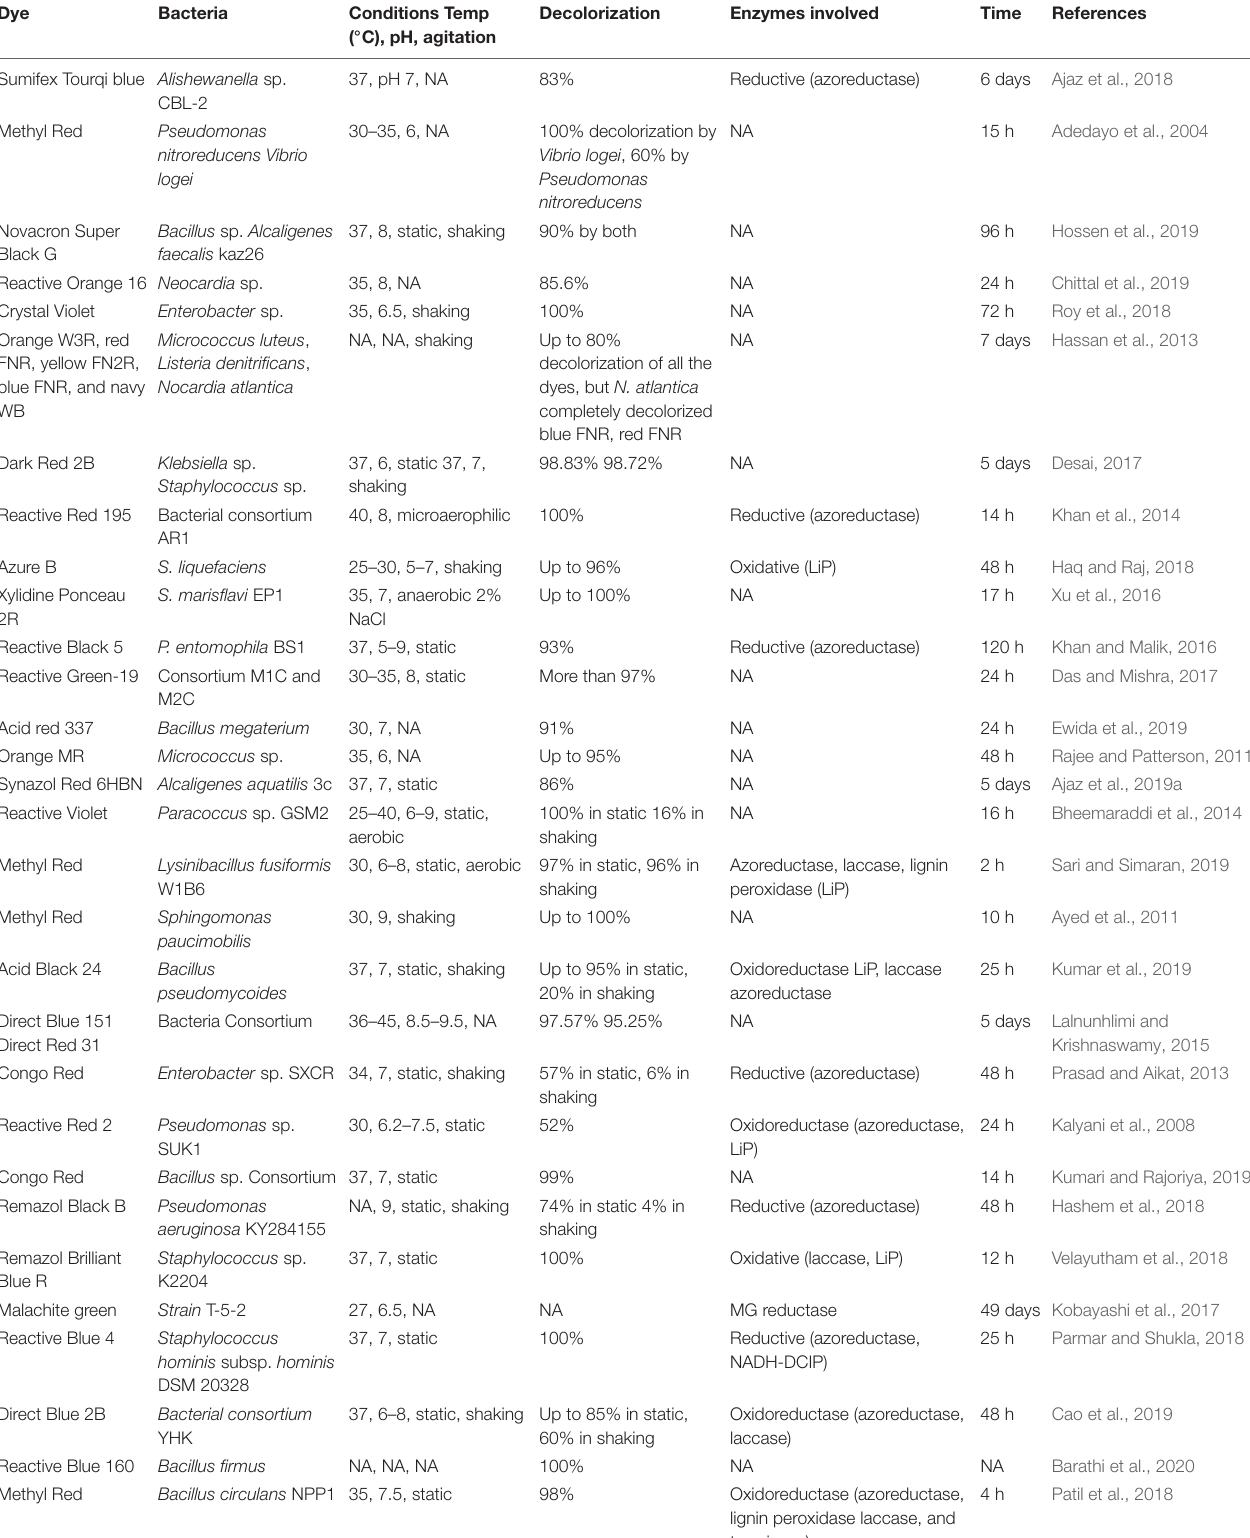
TABLE 2 | Decolorization of dyes by